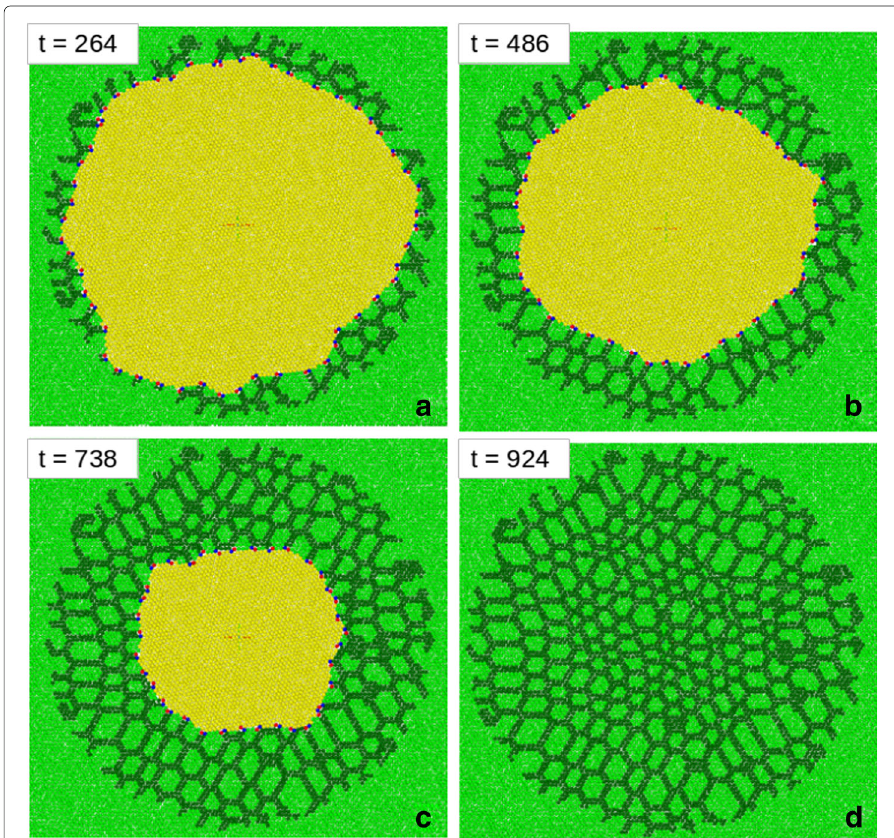
Fig. 8 History of the 5-7 defect pair during the grain shrinkage (dark green) at reduced time a ) t = 264, b ) t = 486, c ) t = 738, d ) t = 924. Their traces form a regular pattern of hexagonal-shaped cells (for the color code see Fig.